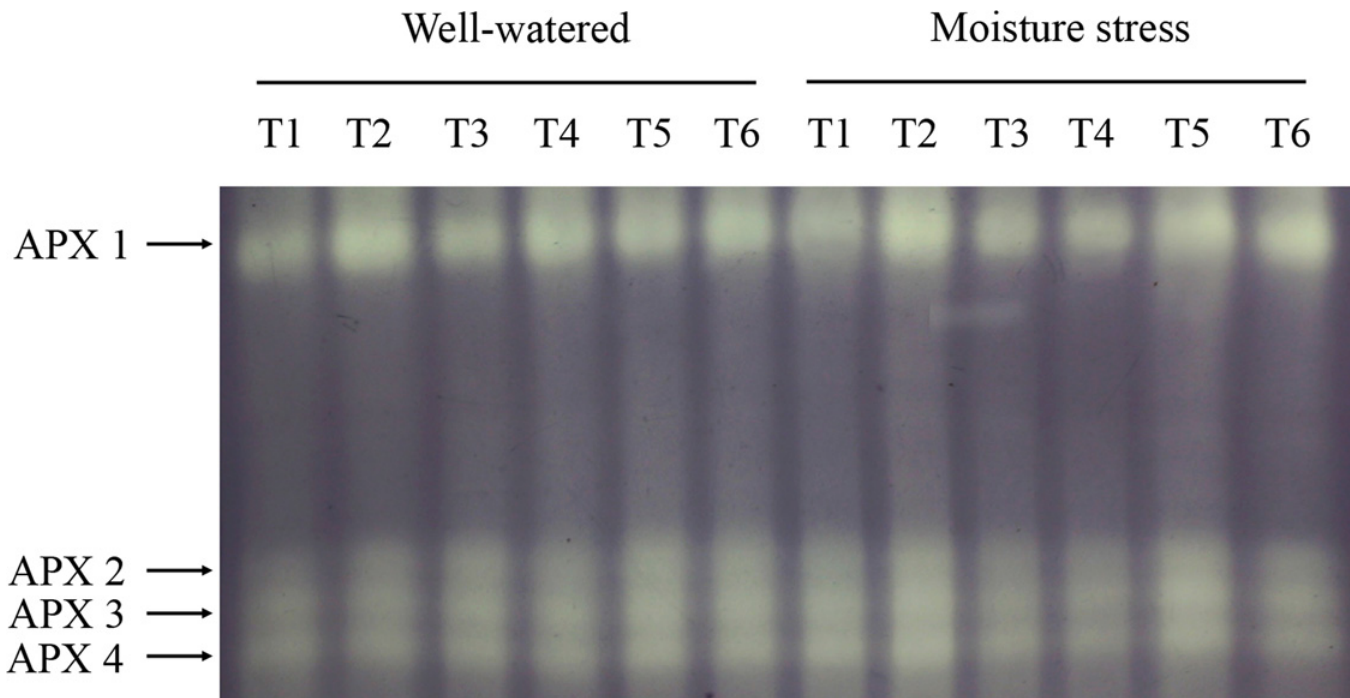
Fig 7. Native gel stained for the activity of APX isoforms of drought stressed creeping bentgrass treated with cytokinin trans -zeatin riboside (CK) and nitrogen. T1 to T6 represent low N + CK0, low N + CK100, low N + CK10, high N + CK0, high N + CK100, high N + CK10 of creeping bentgrass at 40 d, respectively.